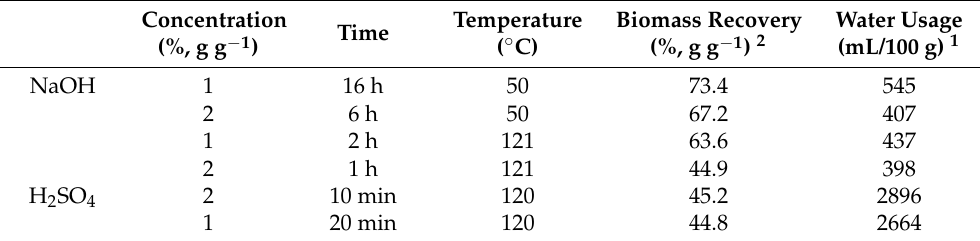
Table 1. Pretreatment conditions, biomass recovery and water